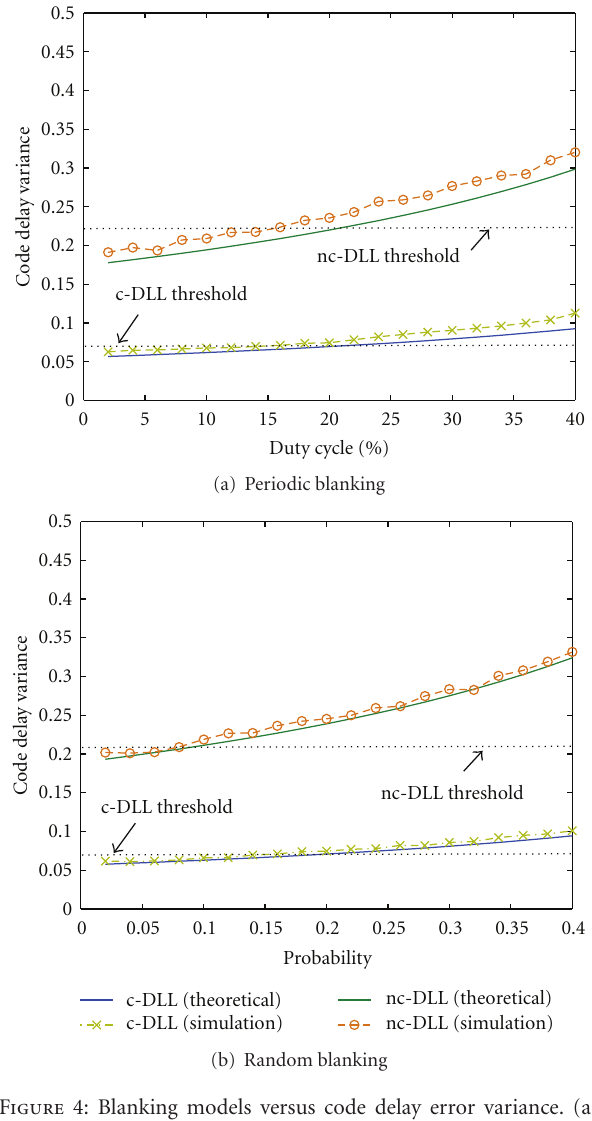
Figure 4: Blanking models versus code delay error variance. (a) Periodic blanking; (b) random